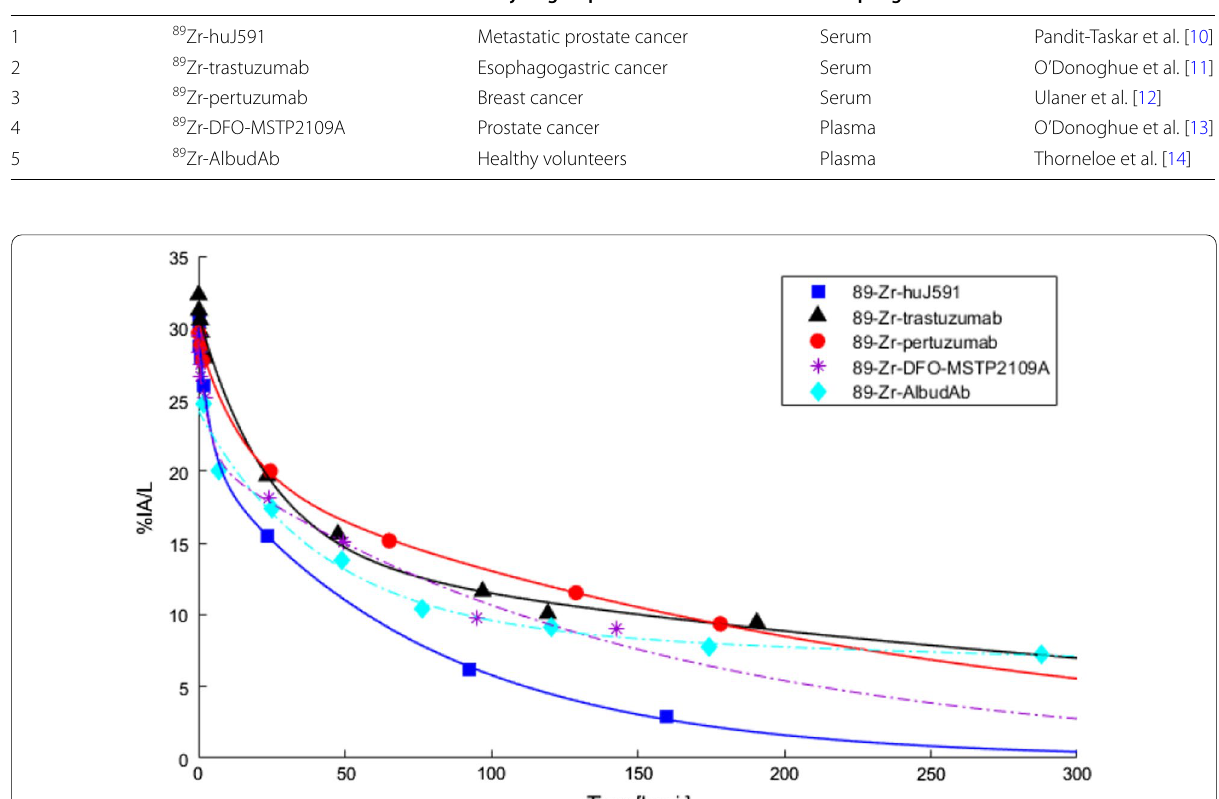
Fig.1 Plasma or serum activity concentrations in percentage injected activity per liter as a function of time in hours post‑injection for 89 Zr‑huJ591 (191.3 9 MBq, 25 mg) [10], 89 Zr‑trastuzumab (185 MBq, 50 mg) [11], 89 Zr‑pertuzumab (74 MBq, 20 or 50 mg) [12], 89 Zr‑DFO‑MSTP2109A (184 MBq, ± 10 mg) [13] and 89 Zr‑AlbudAb (14 MBq, 1 mg) [14]. The bold lines represent the input functions used for the simulations, and the dashed lines represent the input functions not included in the simulations. %IA/L